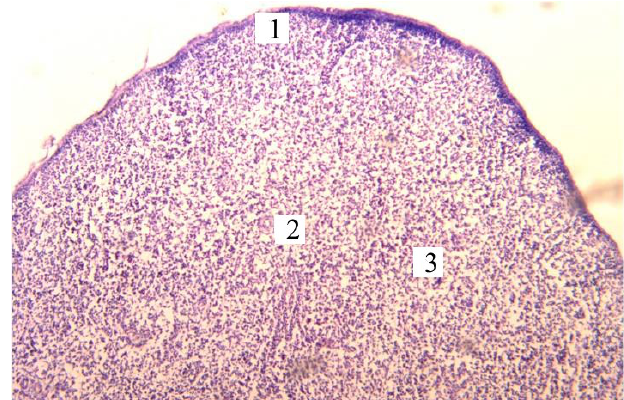
Fig. 1. Microscopic structure of the spleen of a vaccinat- ed one-day-old chicken: 1 – capsule; 2 – blood vessel; 3 – red pulp. Hematoxylin and eosin. x 100 In the 15-day-old chickens of the experimental group, we noted only different accumulations of lymphoid tissue that did not have a clear border (Fig. 2).